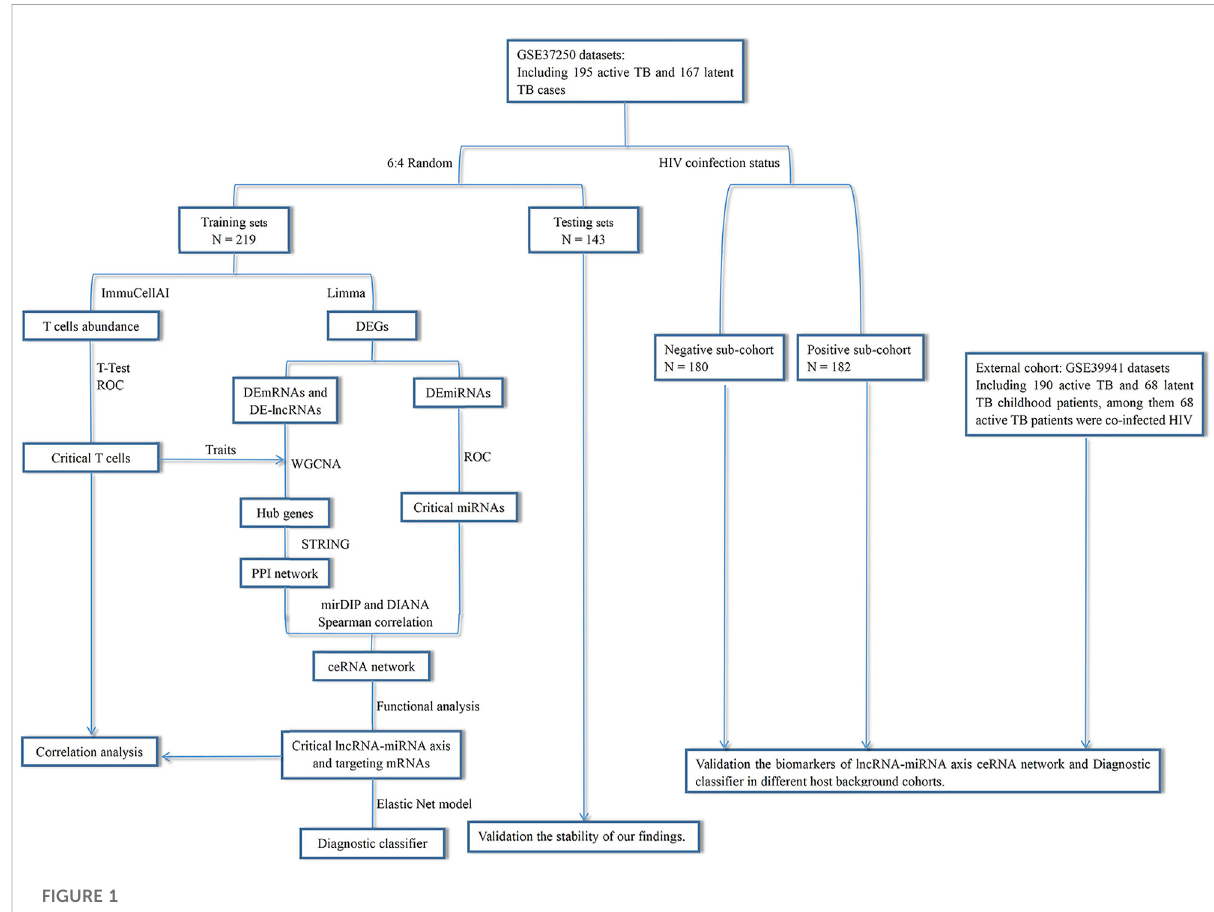
FIGURE 1 Overview of the study